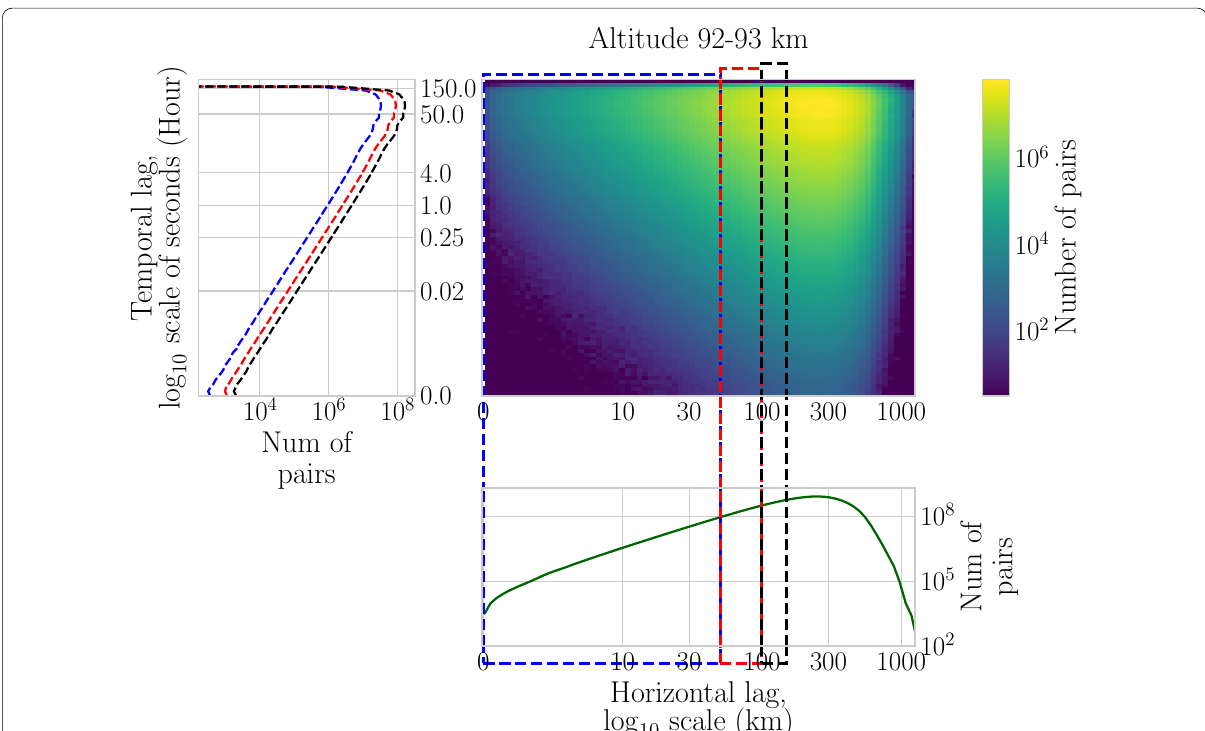
Fig. 5 Two-dimensional histogram shows the measurement pairs between 92 and 93 km in altitude. The black, red and, blue dashed boxes correspond to the meteor pairs used in three different horizontal scale analysis; 0–50 km, 50–100 km, 100–150 km, respectively. The temporal lag histogram on the left shows the selected meteor pairs for the three different horizontal scales, where colours of dashed lines follow the dashed box colours in the 2D histogram. The horizontal lag histogram on the bottom shows the total meteor pairs averaged over all different temporal